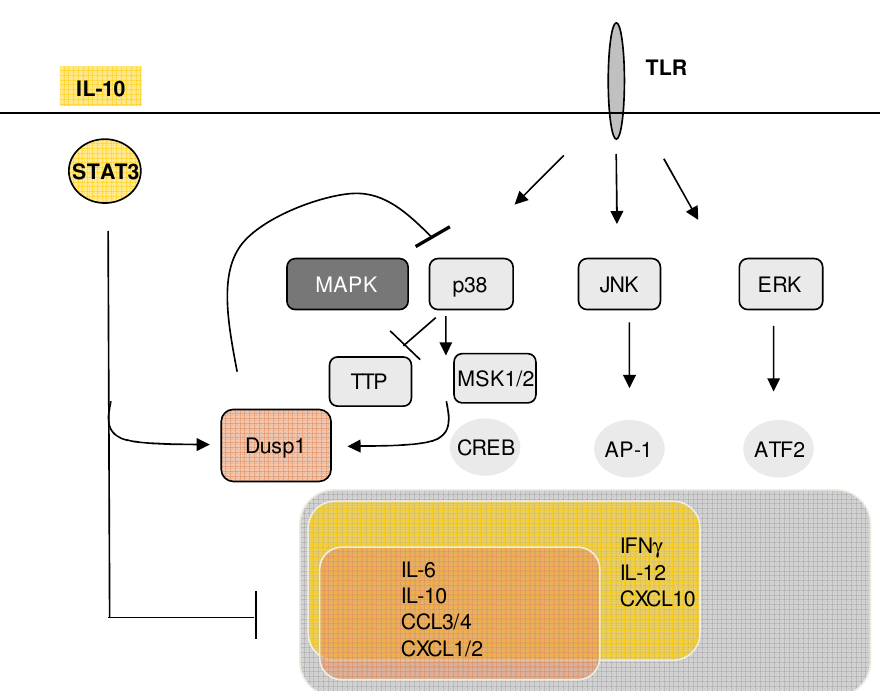
Figure 3. Mechanism of DUSP1 regulation of cytokine expression in Toll-like receptor (TLR)-stimulated macrophages. DUSP1 expression is induced after TLR triggering via MAPK activation and strongly enhanced by IL-10-STAT3 signaling. Preferential inhibition of p38 activity by DUSP1 down-regulates the expression of a subset of cytokines by interfering with MSK1 / 2-dependent transcription factors and through the control of mRNA decay via the post-translational regulation of TTP. See text for references and details.